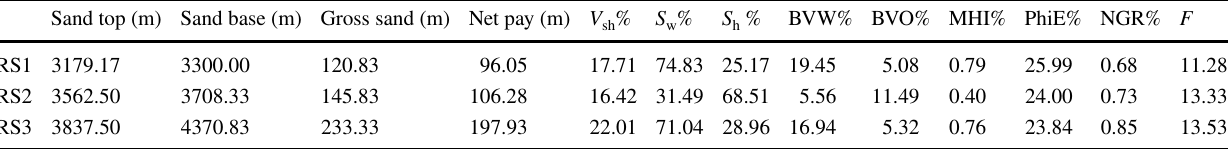
Table 4 Petrophysical properties of Well 4